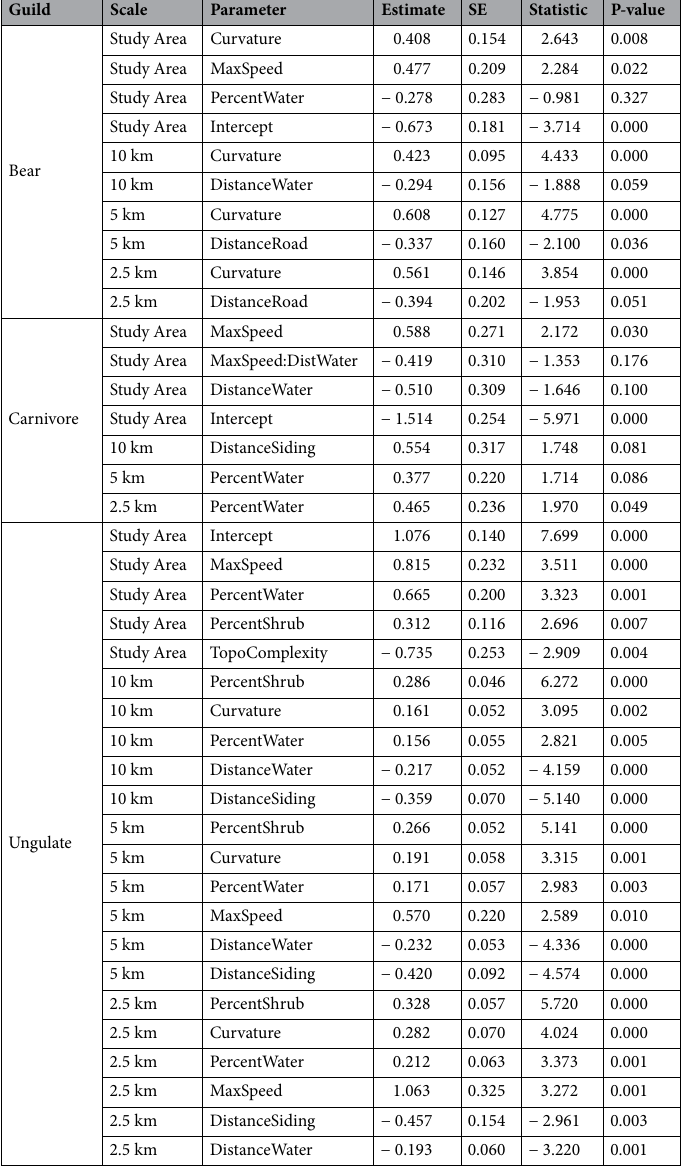
Table 4. Parameter estimates for factors affecting wildlife railroad mortality comparing mortality and available locations using logistic regression (study area) and conditional logistic regression (paired random and mortality locations). The results show the top ranked model for each guild and spatial